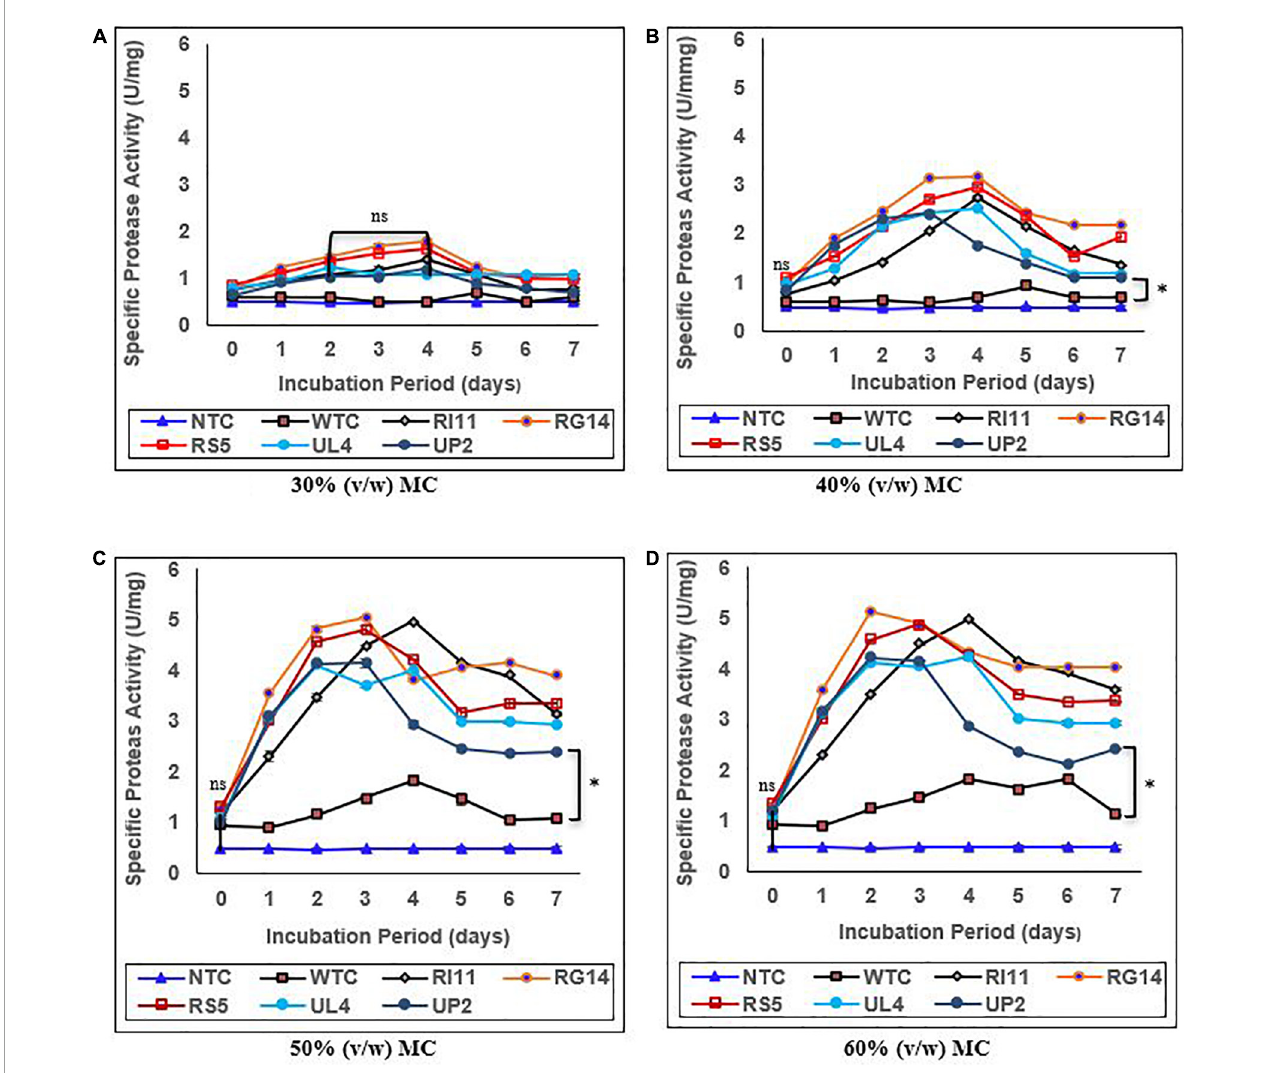
FIGURE3 Effect of moisture contents on the specific endoprotease activity of composite flour during 7 days of solid-state fermentation mediated by probiotic strains. Each value represents mean ± SEM, n = 3. NTC, non-treated control; WTC, water-treated control; R111, L. plantarum RI11; RG14; L. plantarum RG14; RS5, L. plantarum RS5; UL4, L. plantarum UL4; UP2, P. pentosaceus UP2. (A) 30% (v/w) moisture content, (B) 40% (v/w) moisture content, (C) 50% (v/w) moisture content, (D) 60% (v/w) moisture content. ∗ Indicate significant difference ( p ≤ 0.05). ns Not significantly